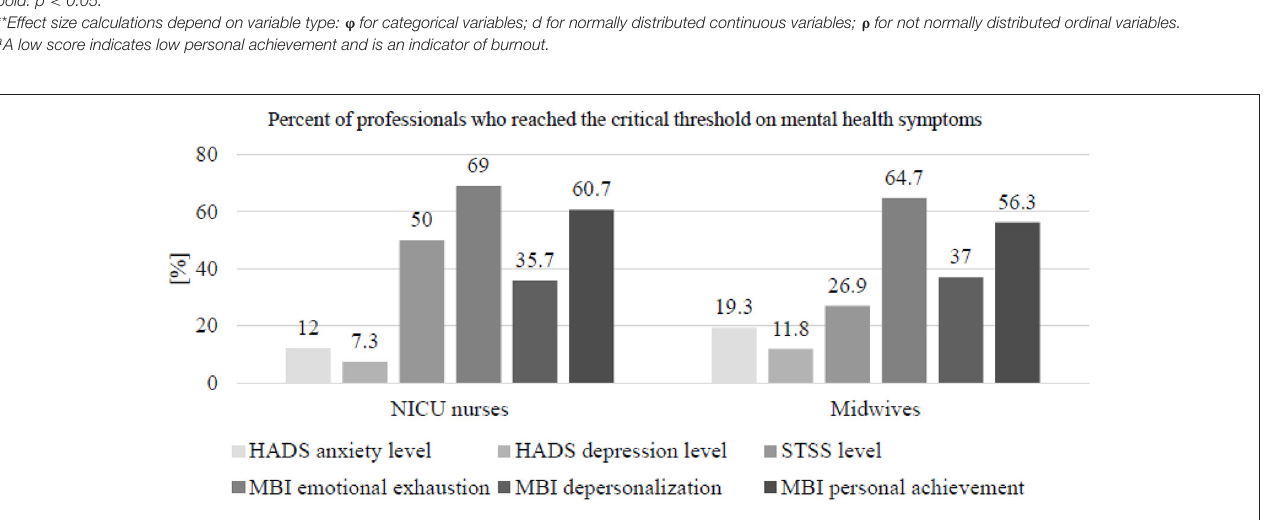
FIGURE 1 | Importance of mental health symptoms by professional group. Severity levels and critical thresholds are defined by authors of each test as follows: HADS anxiety and HADS depression: moderate or severe symptoms. STSS: moderate, high or severe symptoms. MBI: moderate or high